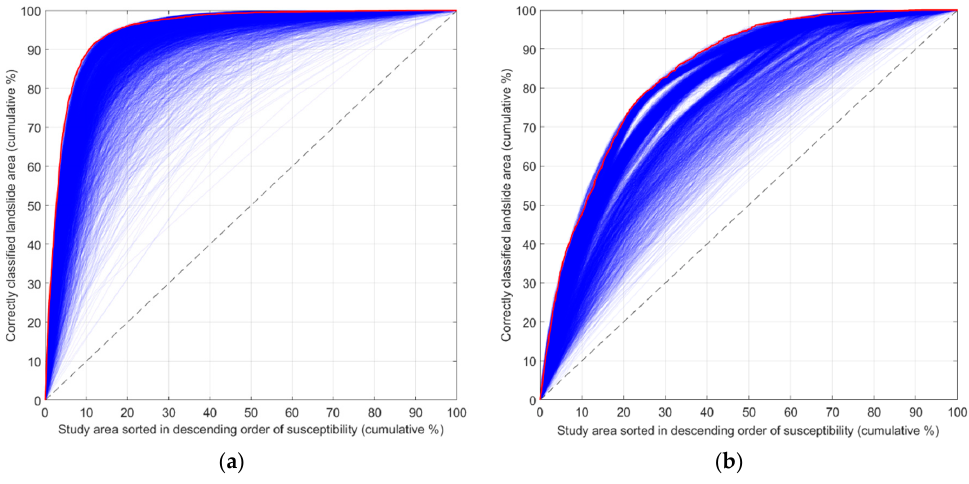
Figure 6. Success Rate Curves (SRCs) resulting from the 4095 susceptibility models computed for: ( a ) falls and ( b ) slides.